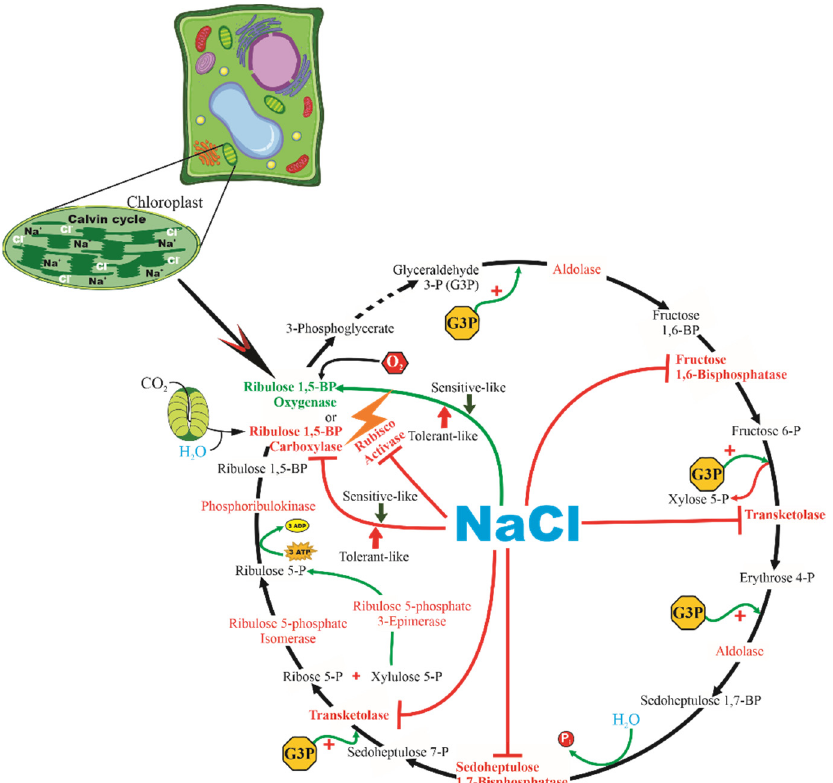
Figure 6. Model proposing that the Na + and Cl − ions promote the downregulation of many enzymes, such as RuBisCO activase, fructose 1,6-bisphosphatase, transketolase, sedoheptulose 1,7-bisphosphatase, and ribulose 5-phosphate isomerase, inhibiting the conversion of ribose 5-phosphate to ribulose 5-phosphate. On tolerant-like plants, Na + and Cl − promote the downregulation of the carboxylase activity and promote the oxygenase activity of ribulose 1,5-bisphosphatase carboxylase-oxygenase. On the other hand, on sensitive-like plants, Na + and Cl − promote the downregulation of the oxygenase activity of ribulose 1,5-bisphosphatase carboxylase-oxygenase, thus promoting carboxylase activity. Model constructed using data presented by Lin, Li [98] and Sivakumar, Sharmila [48].